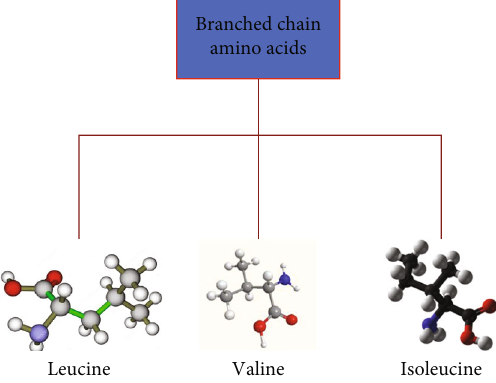
Figure 5: Classi fi cation of branched chain amino